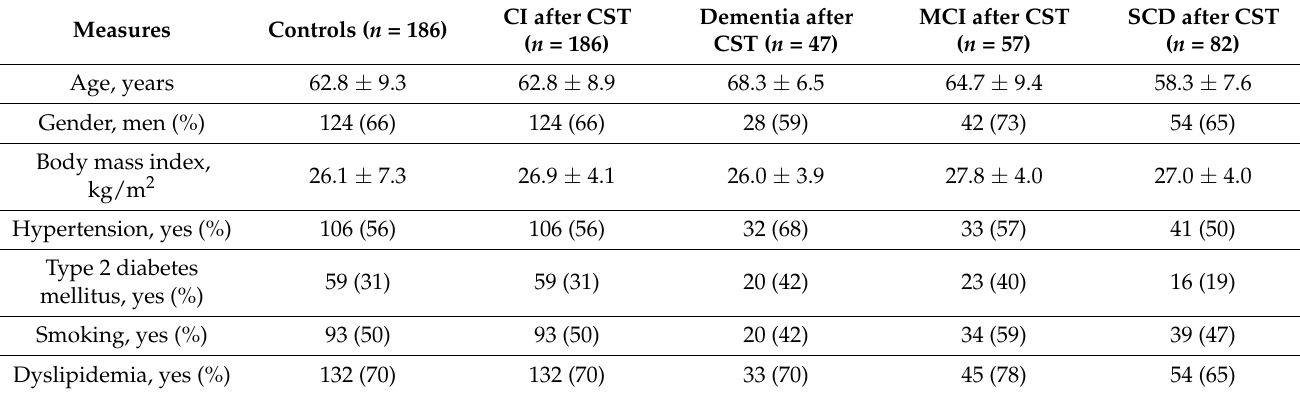
Table 1. Sample characteristics at the time of cardiac stress testing overall and by final